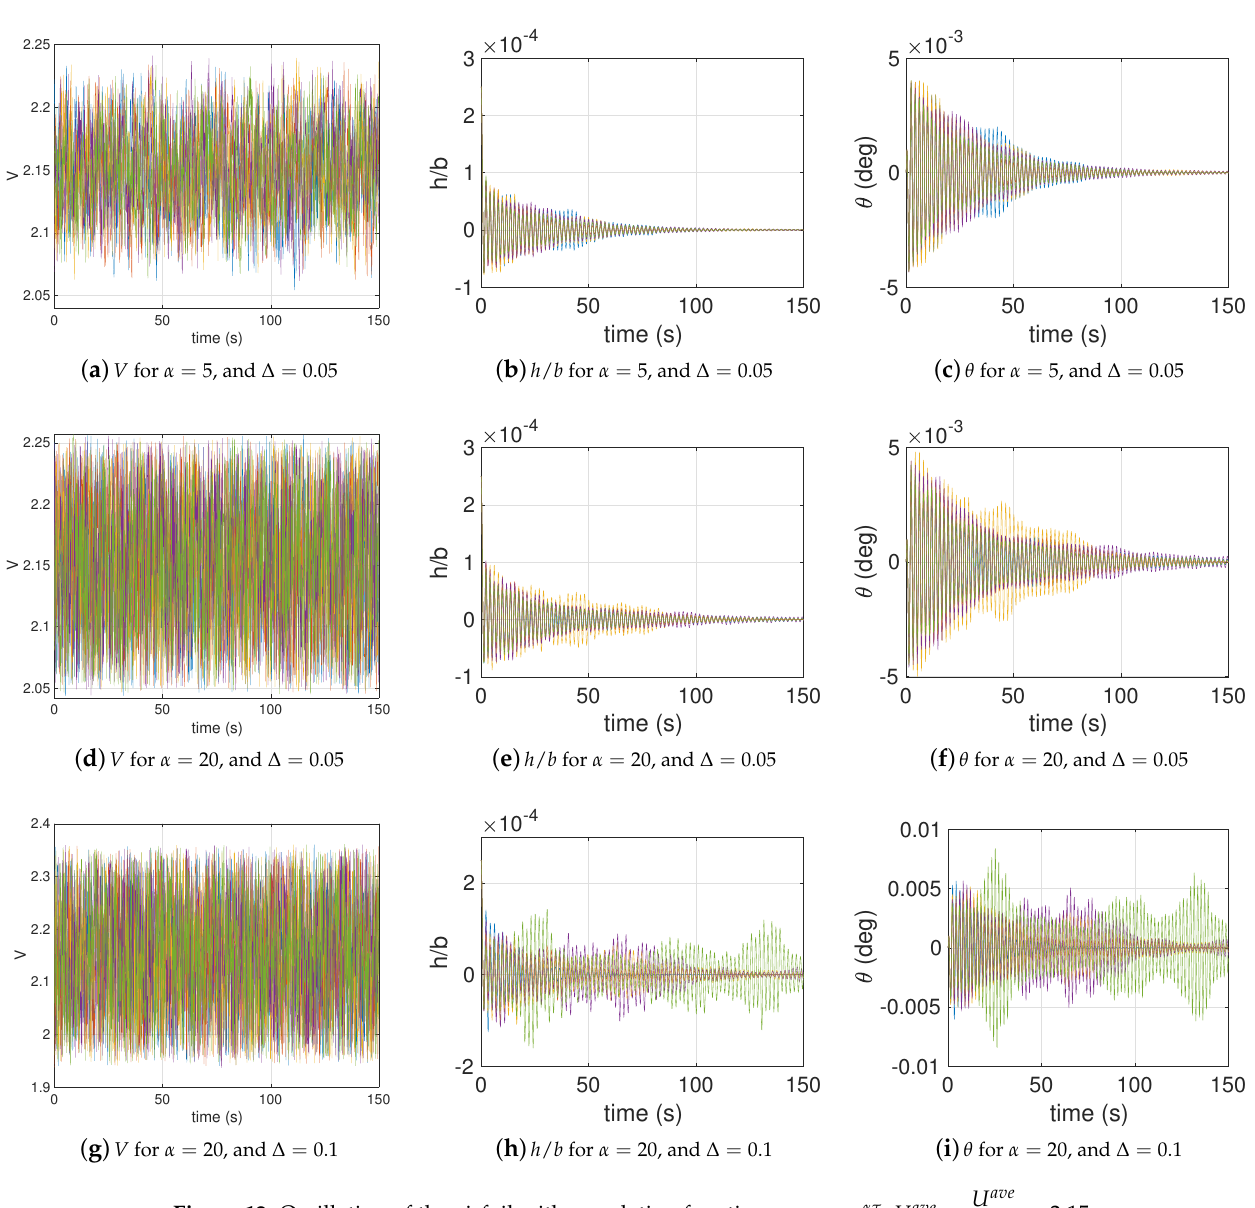
Figure 12. Oscillation of the airfoil with correlation function, r xx = e − ατ , V ave =